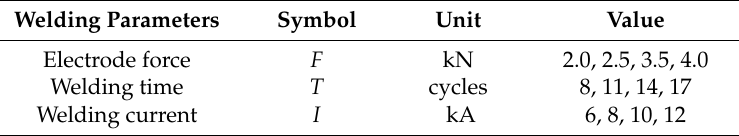
Table 2. Welding parameters employed during the RSW